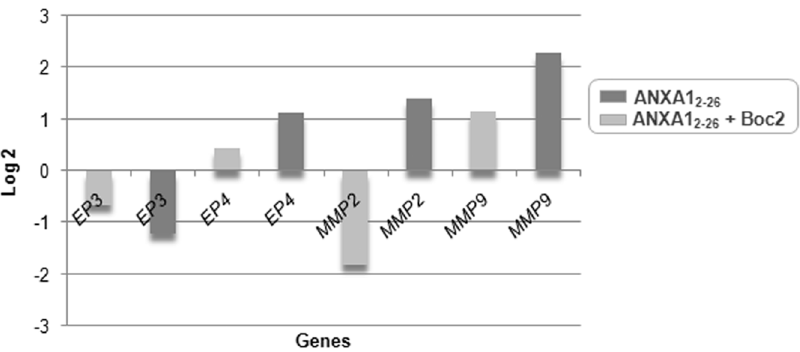
Fig. 6. Gene expression in Hep-2 cells using real-time PCR. ( A ) Down- and up-regulated expression of MMP2 and MMP9 , respectively, after ANXA1 2–26 treatment. ( B ) Overexpression of EP4 , MMP2 and MMP9 , and down-regulation of EP3 after ANXA1 2–26 + Boc. Hep-2 cells were seeded in MEM-Earle medium at a density of 2 6 10 6 cells in 75-cm 2 culture flasks, and then were incubated with serum-free medium, 24 hours prior to the addition of ANXA1 2–26 (1 m M) and ANXA1 2–26 (1 m M) + Boc2 (10 m M). All of the experiments are representative of three separate experiments. GAPDH was used as the internal reference and the control sample was used as the calibrator. Values were Log2 transformed (y-axis) so that all values below 2 1 indicated down-regulation in gene expression while values above 1 represented up-regulation compared with control